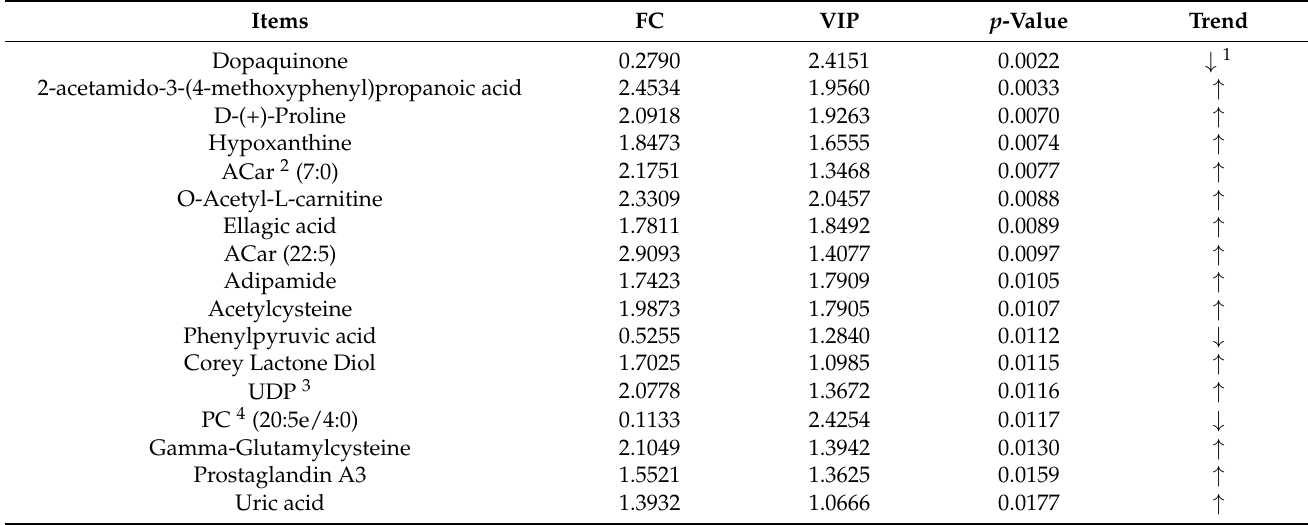
Table 9. Differential metabolites in positive ion